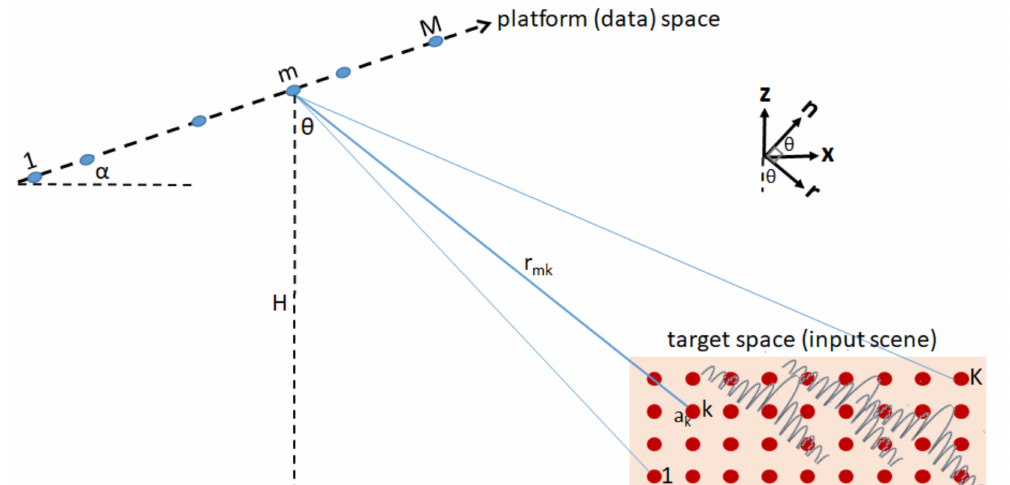
Figure 9. The geometry used in tomographic raw data generation in 2D. Blue and red circles represent platforms and targets, respectively. Platforms are distributed along the baseline which is tilted by α relative to horizontal. Targets are distributed in the vertical and horizontal directions. Look angle is θ . Slant ranges from reference platform to a few targets as well as the range spread functions are